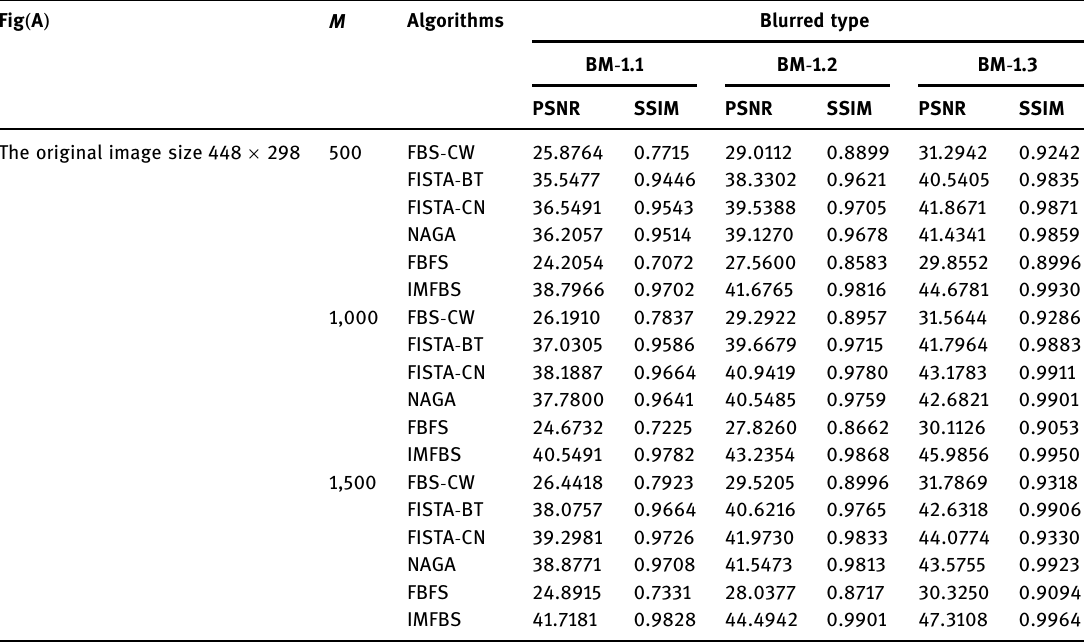
Table 2: The results of deblurred images for each algorithm Fig ( A